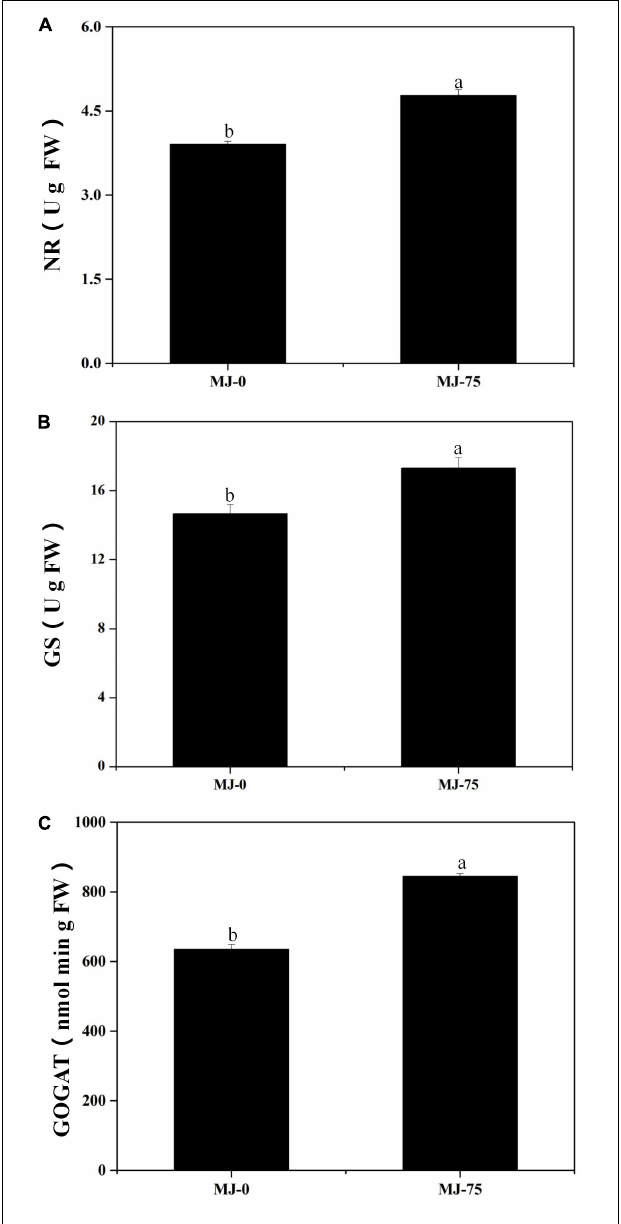
FIGURE 4 | Effects of MeJA on nitrogen metabolism of L. longituba seedlings. (A) The nitrate reductase (NR) activities in MJ-0 and MJ-75 treatments. (B) The glutamine synthetase (GS) activities in MJ-0 and MJ-75 treatments. (C) The glutamate synthase (GOGAT) activities in MJ-0 and MJ-75 treatments. Error values indicate the standard deviation (SD). Least-significant difference test (LSD, p < 0.05) was used to compare the means. Different letters represent significant differences between groups ( N = 3, p <